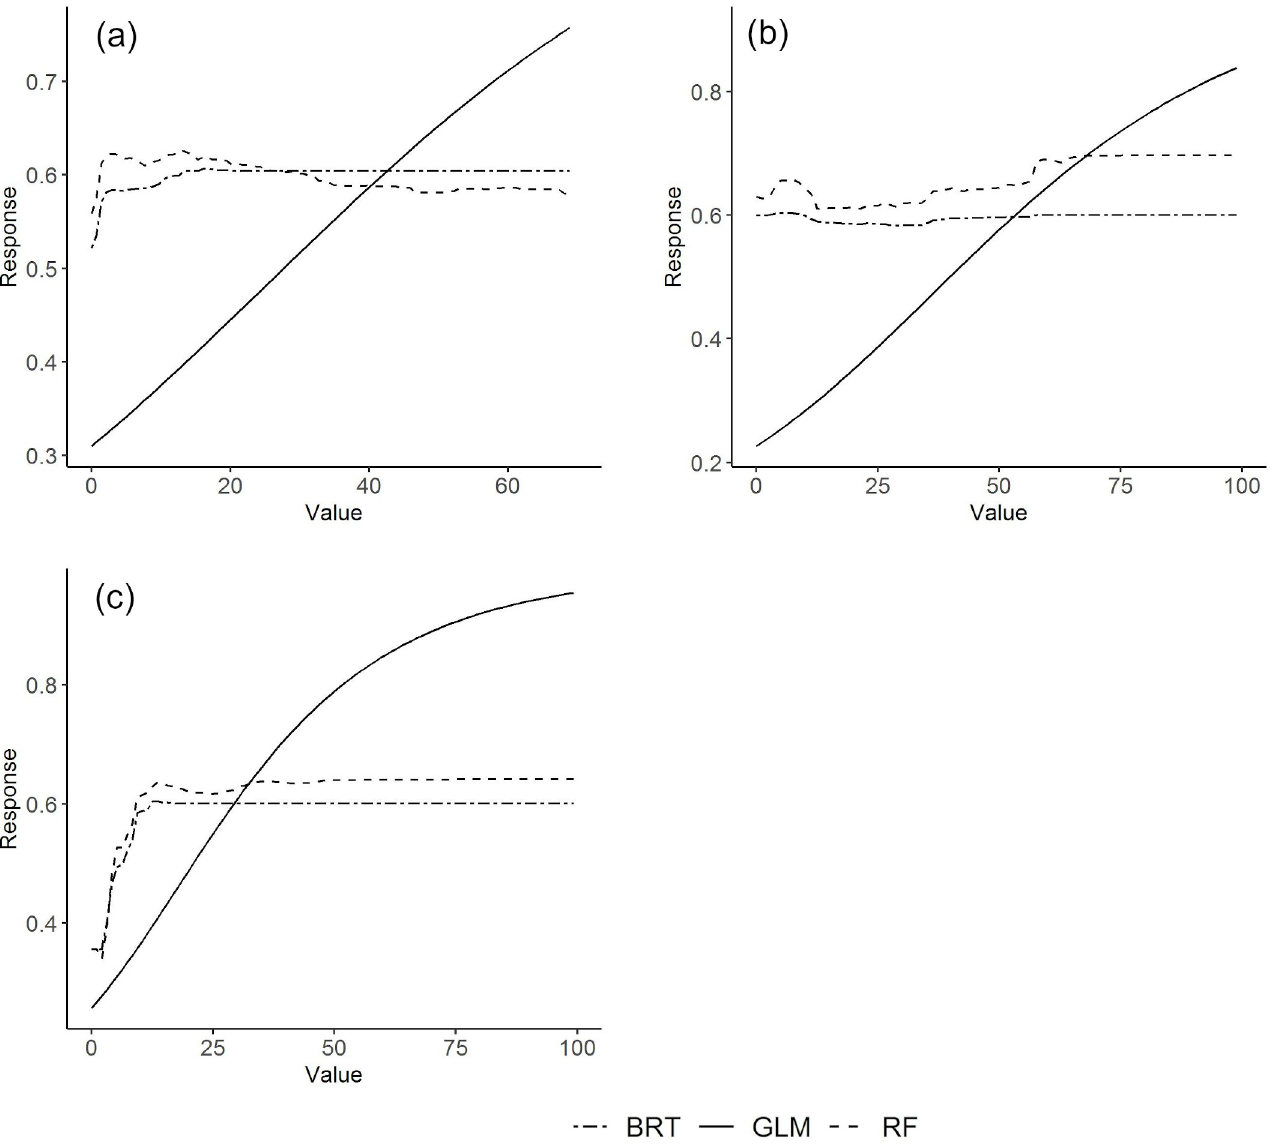
Fig 4. Response curves of predicted suitability for Aedes aegypti along the gradient of most influential predictor variables representing land use and human settlement conditions: a) percentage of area occupied by public equipment; b) residential house density; c) human population density. Generalized additive models were not used as the number of distribution records was insufficient for model